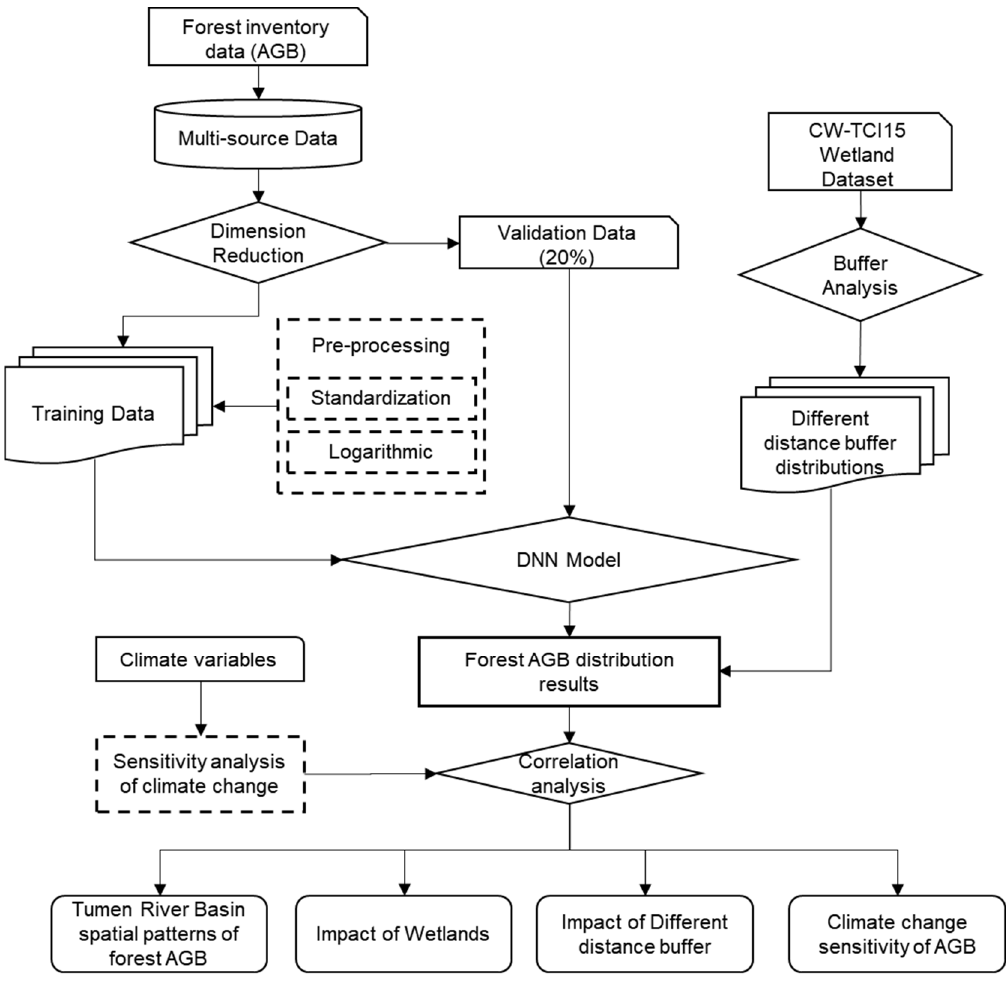
Figure 1. The framework of this study .